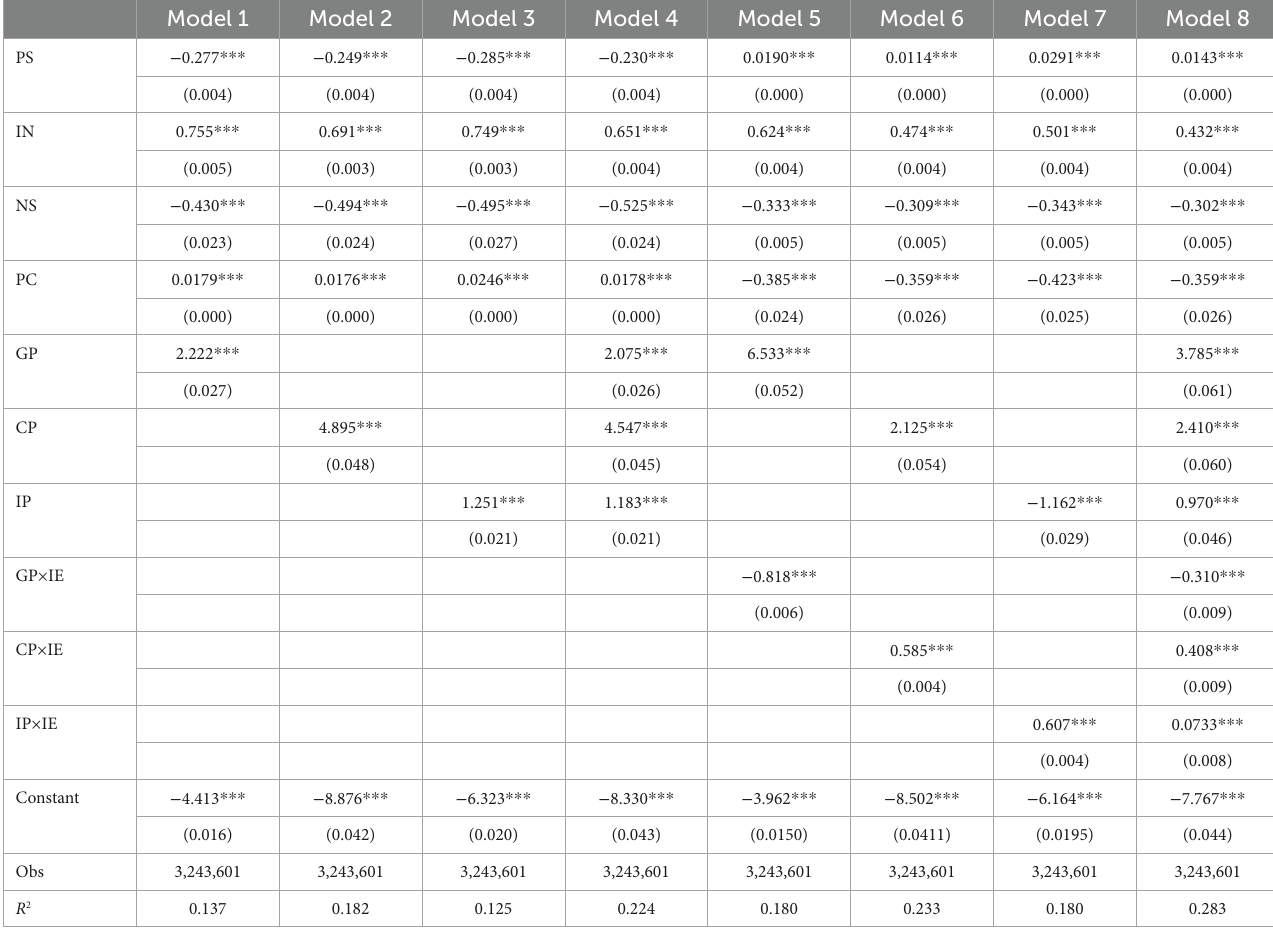
TABLE 3 Robustness tests regarding the influence of multidimensional proximities and intraorganizational collaboration network